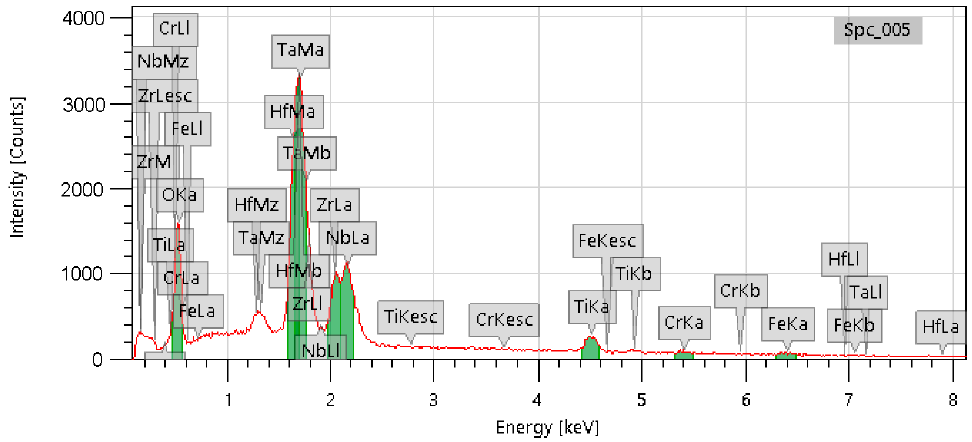
Figure 4. Example of the observed EDXS intensity patterns; sample S18; symbols of elements and X-ray fluorescence transitions are shown.